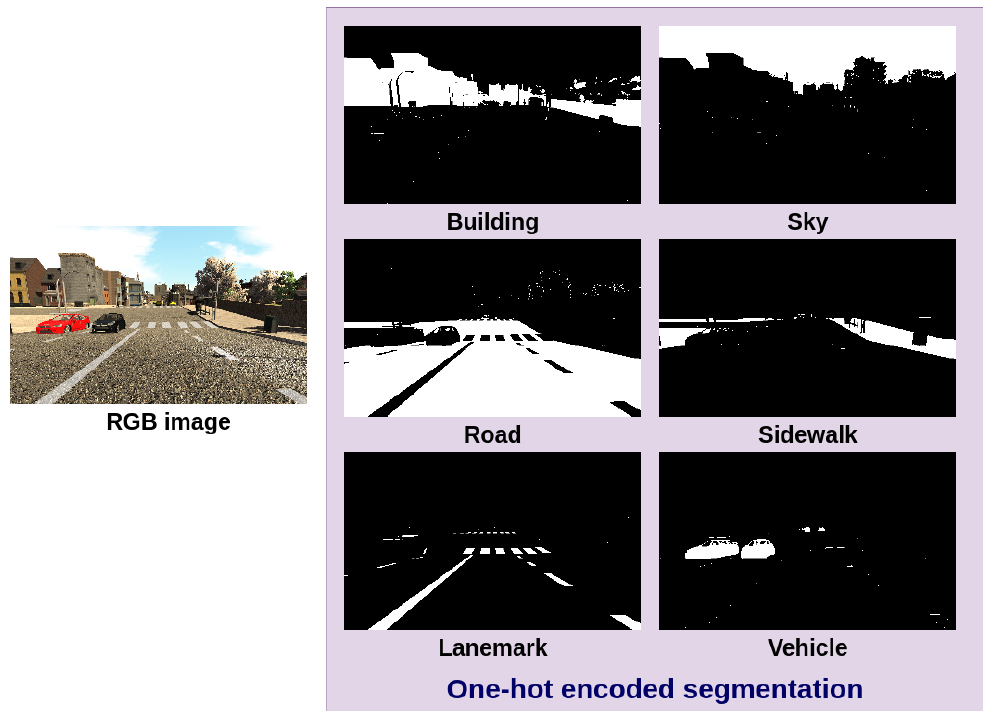
Figure 1. One-Hot Encoded Semantic Segmentation (OHESS) from a RGB image (not all classes are included in the